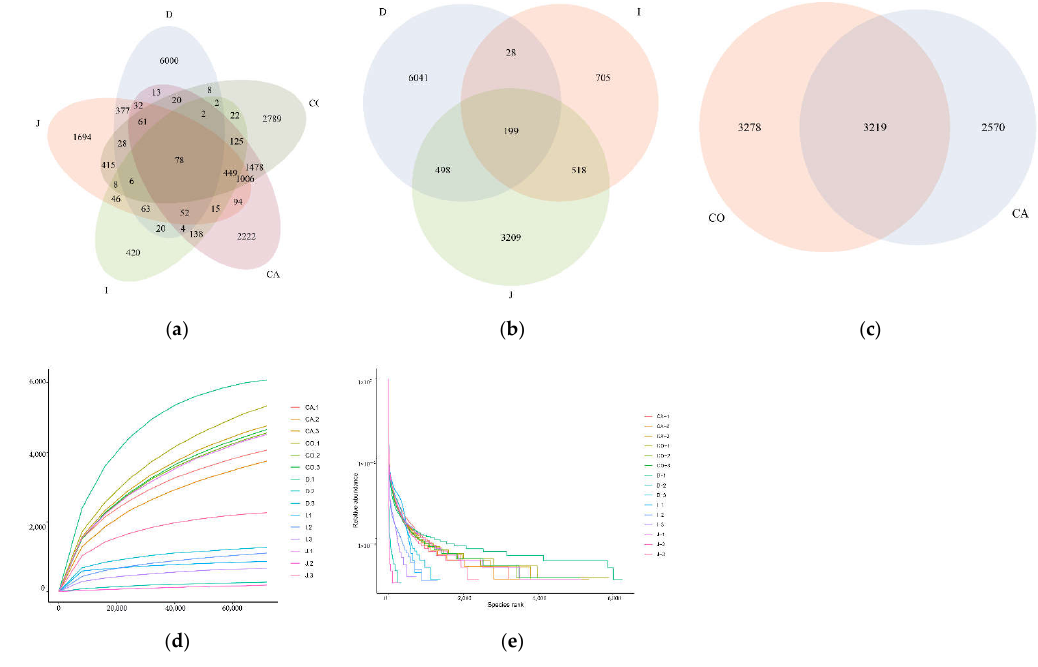
Figure 1. Venn diagram analysis and feasibility analysis based on the OUTs of each part. ( a ) The Venn diagram of each intestinal segment. ( b ) Venn diagram of various parts of the small intestine. ( c ) Venn diagram of various parts of the large intestine. ( d ) The species accumulation curve for each group. ( e ) The rank abundance curve for each group.